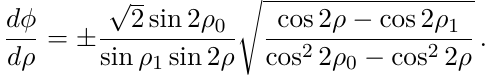
Figure 8 . Typical shapes of spiky strings with three outward spikes in flat space (the left panel) and AdS (the right